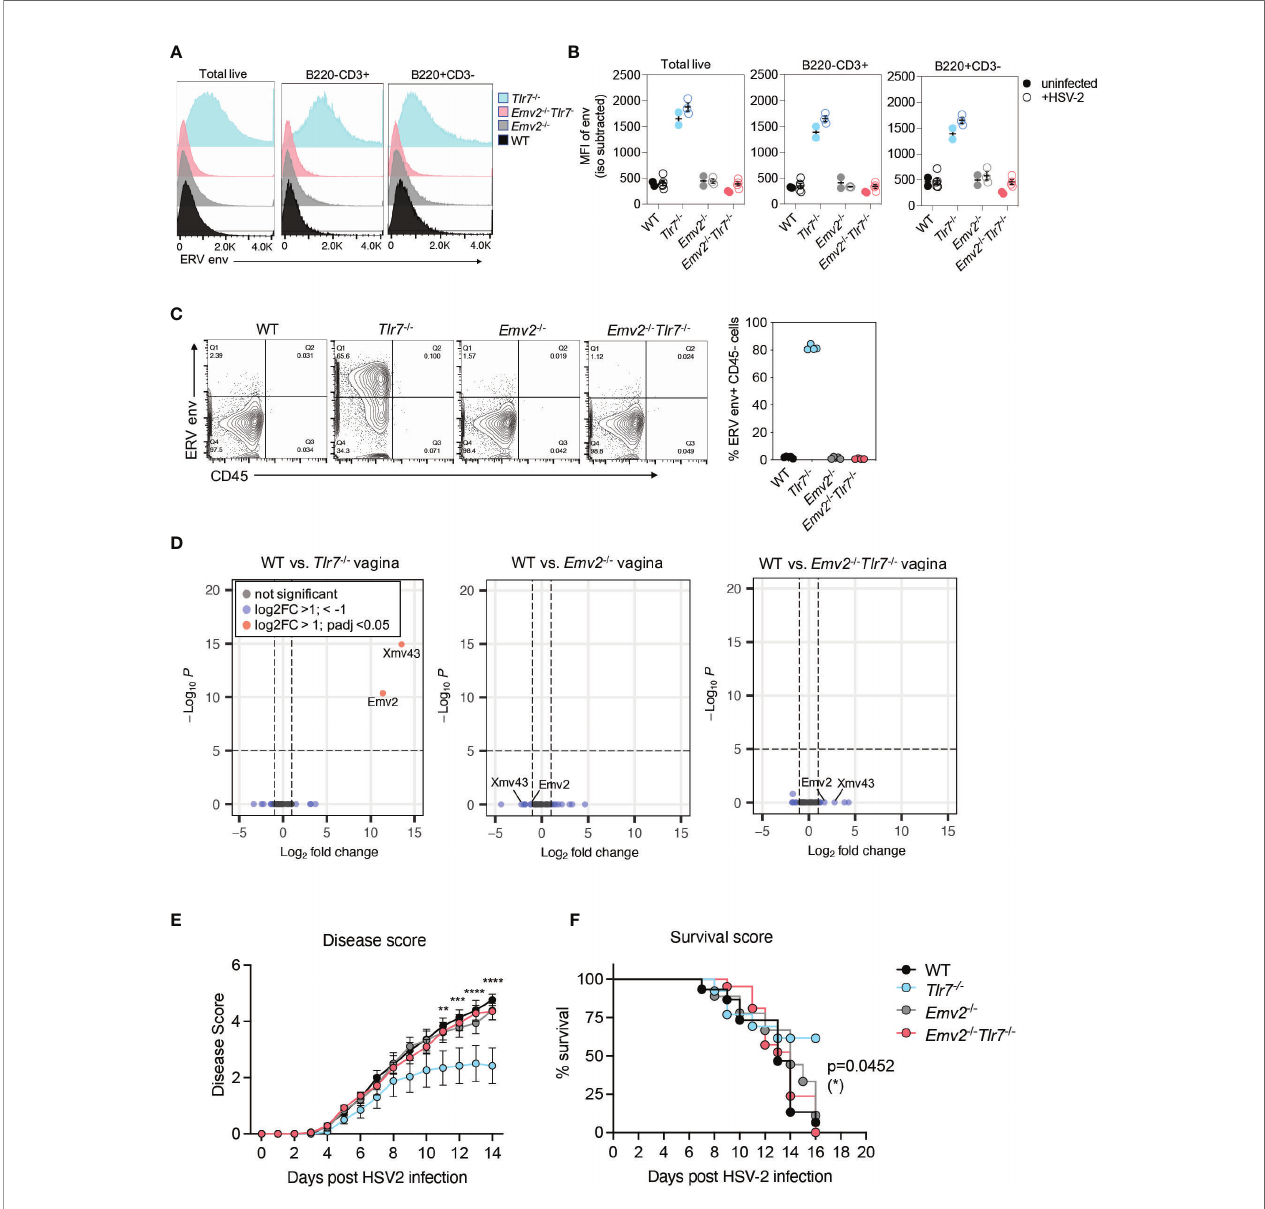
FIGURE 3 | Emv2-encoded ERVs mediate protection against HSV-2. (A) Histograms of ERV envelope expression in the indicated splenocyte populations. Representative histogram of one mouse per genotype within an experiment with 3-5 mice per group. (B) ERV envelope expression data showing data from all mice and comparing splenocytes from uninfected mice ( fi lled circles) with mice from 2 days post HSV-2 infection (open circles). (C) Quanti fi cation of ERV envelope expression on DFJ8 cells at 14 days post co-culture with splenocytes from the indicated mice (n=4 per group), as a proxy measurement for infectious ERVs. CD45 + input splenocytes were excluded to measure ERV envelope only in DFJ8 cells. (D) Differential proviral ERV expression in vaginal tissues from the indicated mice determined by RNA-seq analysis followed by DESeq2 analysis. Data are from 2 mice per group. Indicated mice were infected intravaginally with HSV-2 and disease score (E) and survival (F) were monitored (WT, n=15; Emv2 -/- , n=9; Tlr7 -/- , n=13; Emv2 -/- Tlr7 -/- , n=21). The data are pooled from three independent experiments. Two-way ANOVA Tukey ’ s multiple comparisons test and log-rank (Mantel-Cox) test were performed to calculate signi fi cance for disease score and survival, respectively, between Tlr7 -/- and Emv2 -/- Tlr7 -/- groups. *p < 0.05; **p < 0.01; ***p < 0.001; ****p <